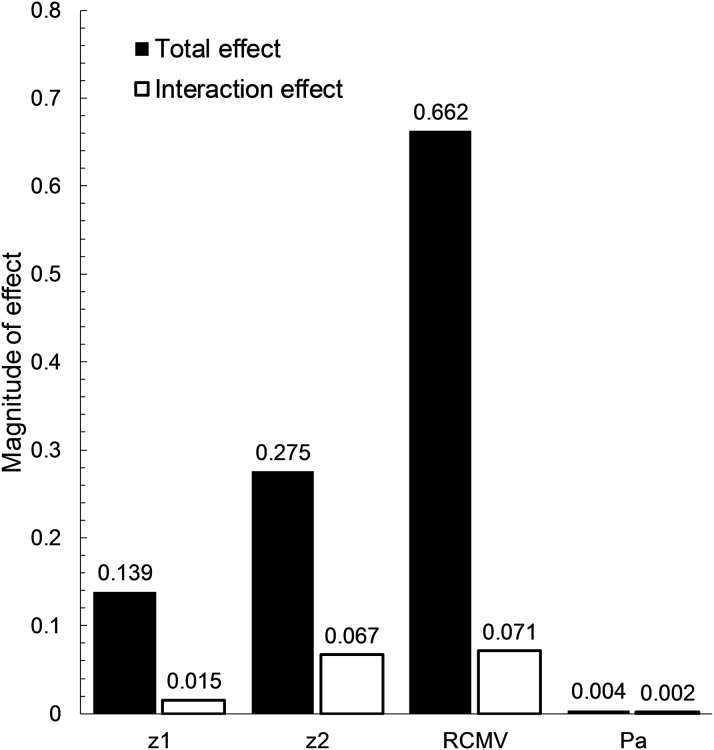
Total and Interaction Model Input EffectsBar chart demonstrating the magnitude of the total (direct and interactions) effect on vFFR caused by the input parameters CMV resistance (RCMV), geometry parameters (z1 and z2) and average proximal pressure (Pa). Abbreviations as in Figure 7.